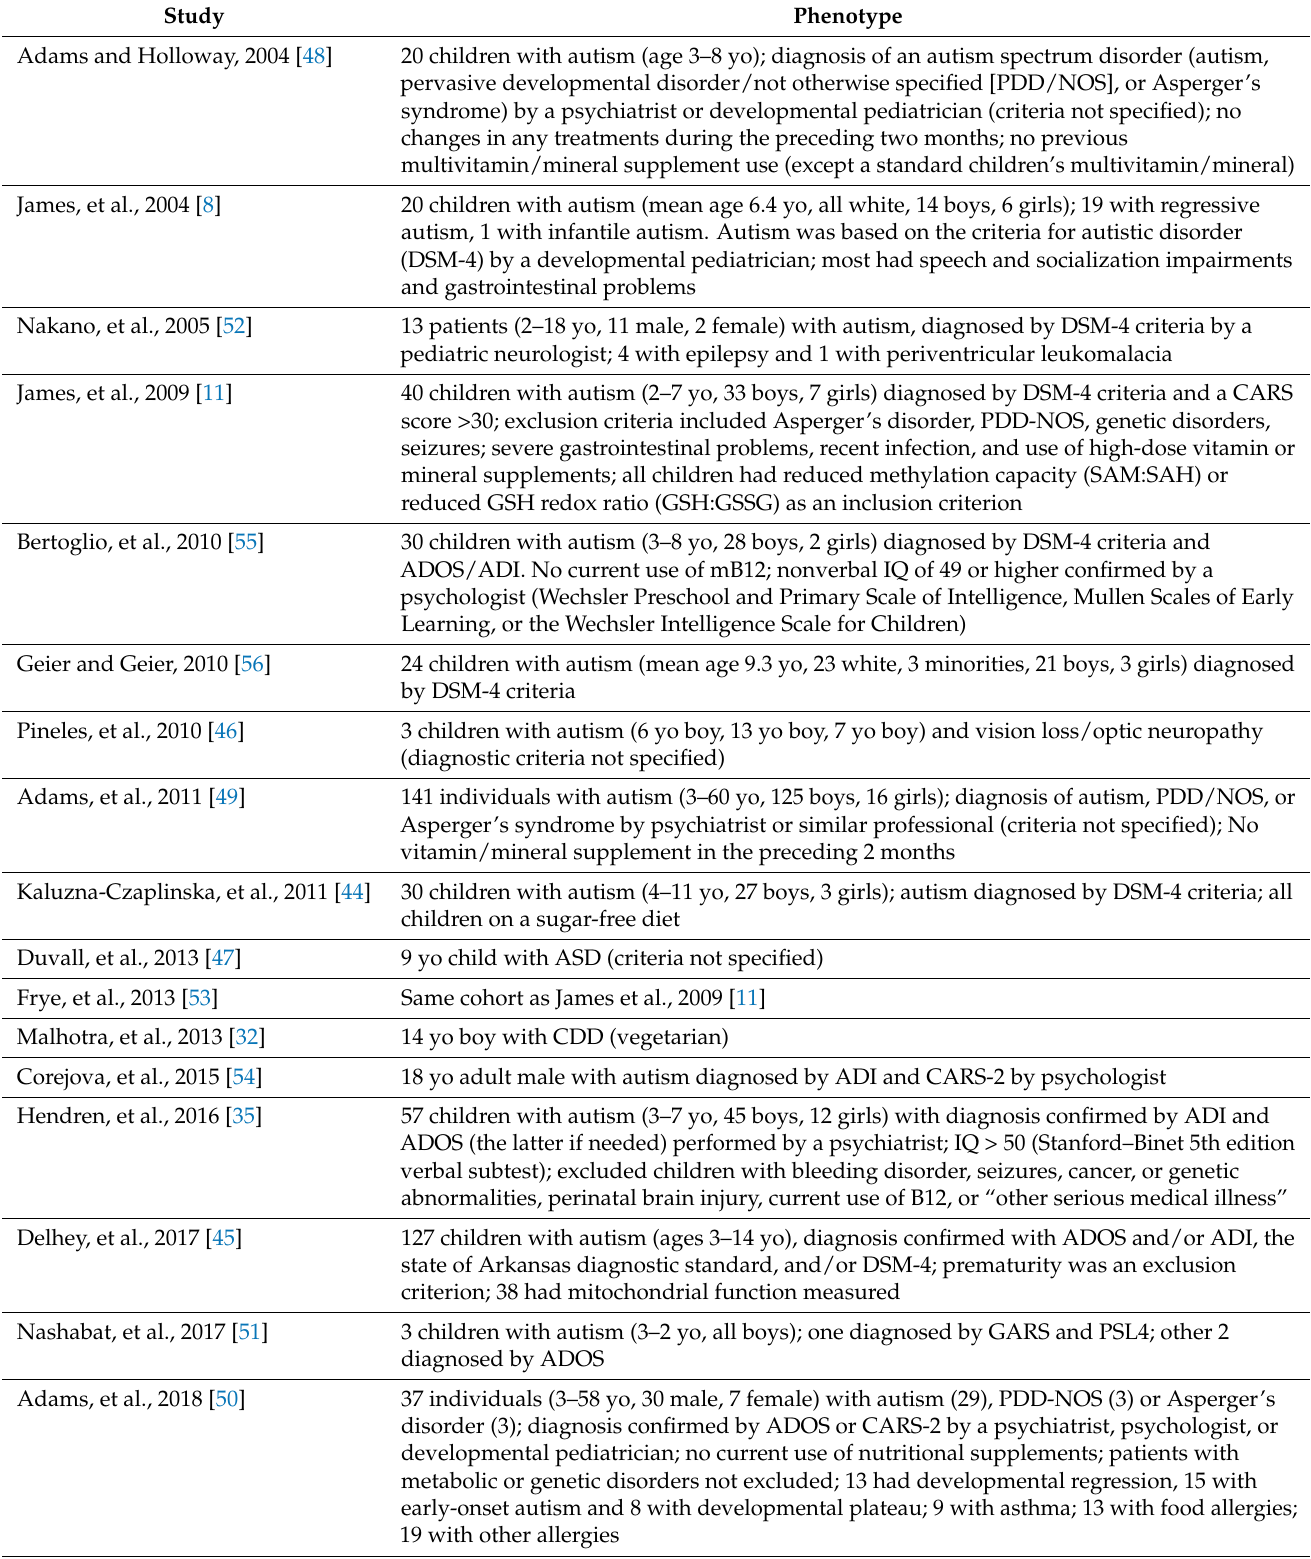
Table 1. Phenotypes of autism in the 17 reviewed studies, by year